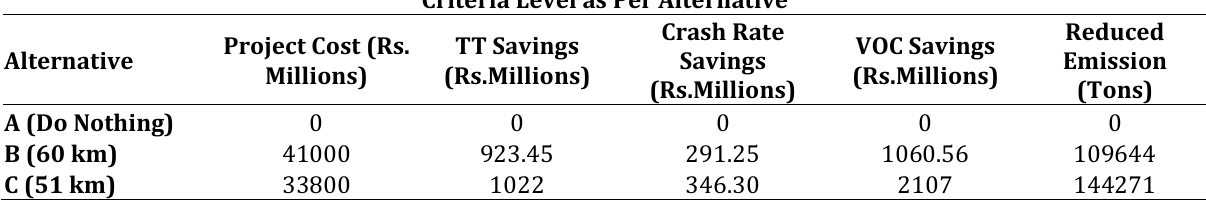
Table 7: Savings Criteria Levels for Each Criterion